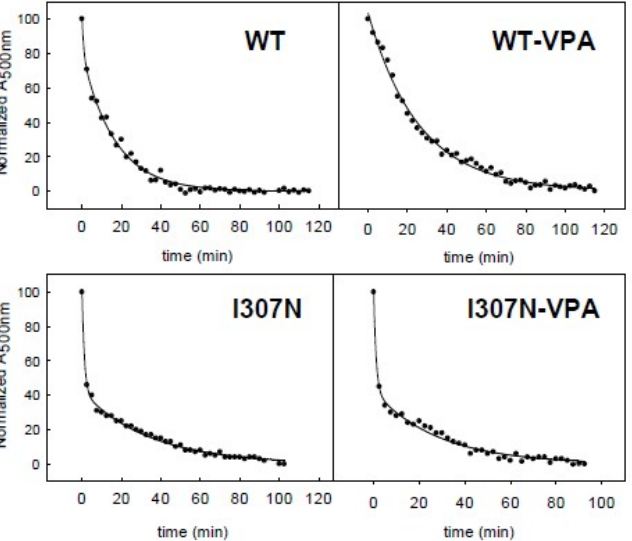
Figure 3. Representative curves for WT and I307N mutant thermal stabilities, in the dark at 48 °C, with and without VPA treatment. The experimental absorbance values at 500 nm were normalized and curve-fitted to an exponential function with Sigma Plot 12.5.